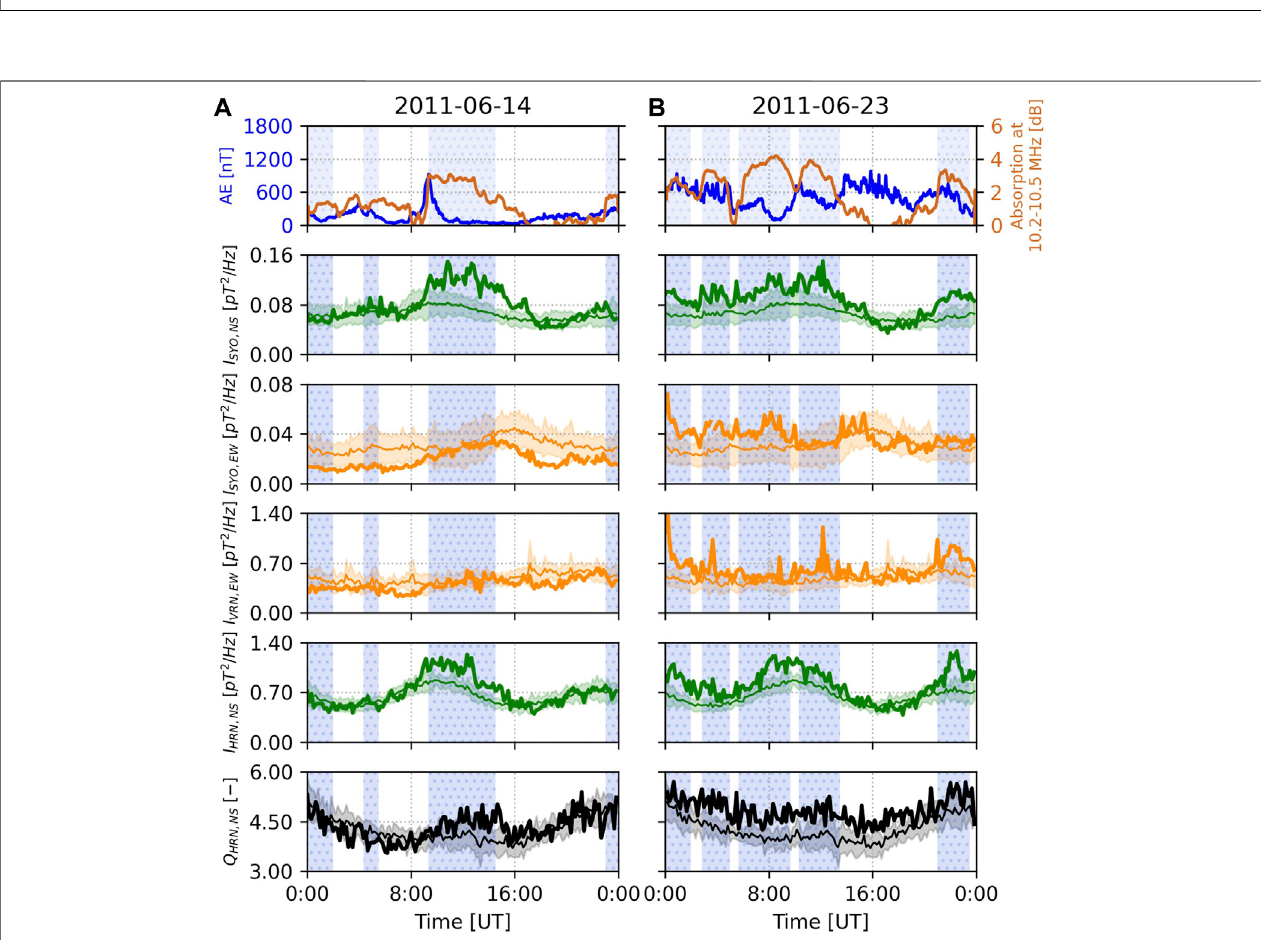
Frontiers in Earth Science |